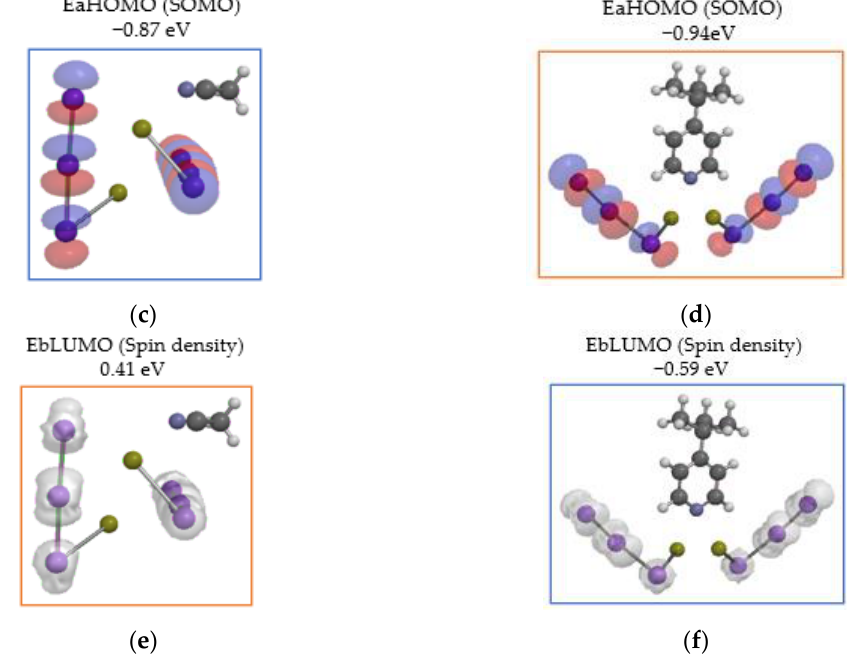
Figure 5. Equilibrium geometry of electron running-state with heat of electron acceptance and energy structures: ( a ) ESPM of [(KI 3 ) 2 and AN] .− ; ( b ) ESPM of [(KI 3 ) 2 and TBP] .− ; ( c ) SOMO configuration of [(KI 3 ) 2 and AN] .− ; ( d ) EbLUMO configuration of [(KI 3 ) 2 and TBP] .− ; ( e ) EbLUMO configuration of [(KI 3 ) 2 and AN] .− ; ( f ) [(KI 3 ) 2 and TBP] .− .